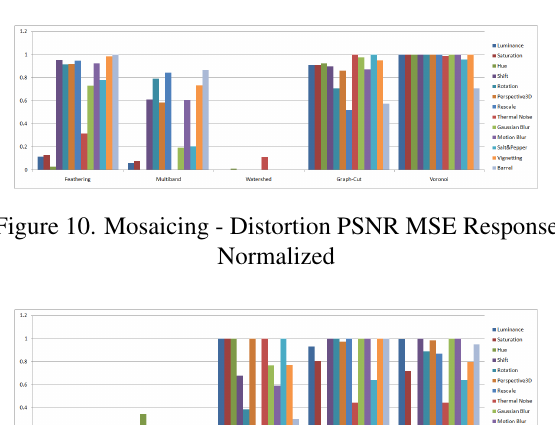
Figure 9. Mosaicing - Distortion PSNR MSE Response